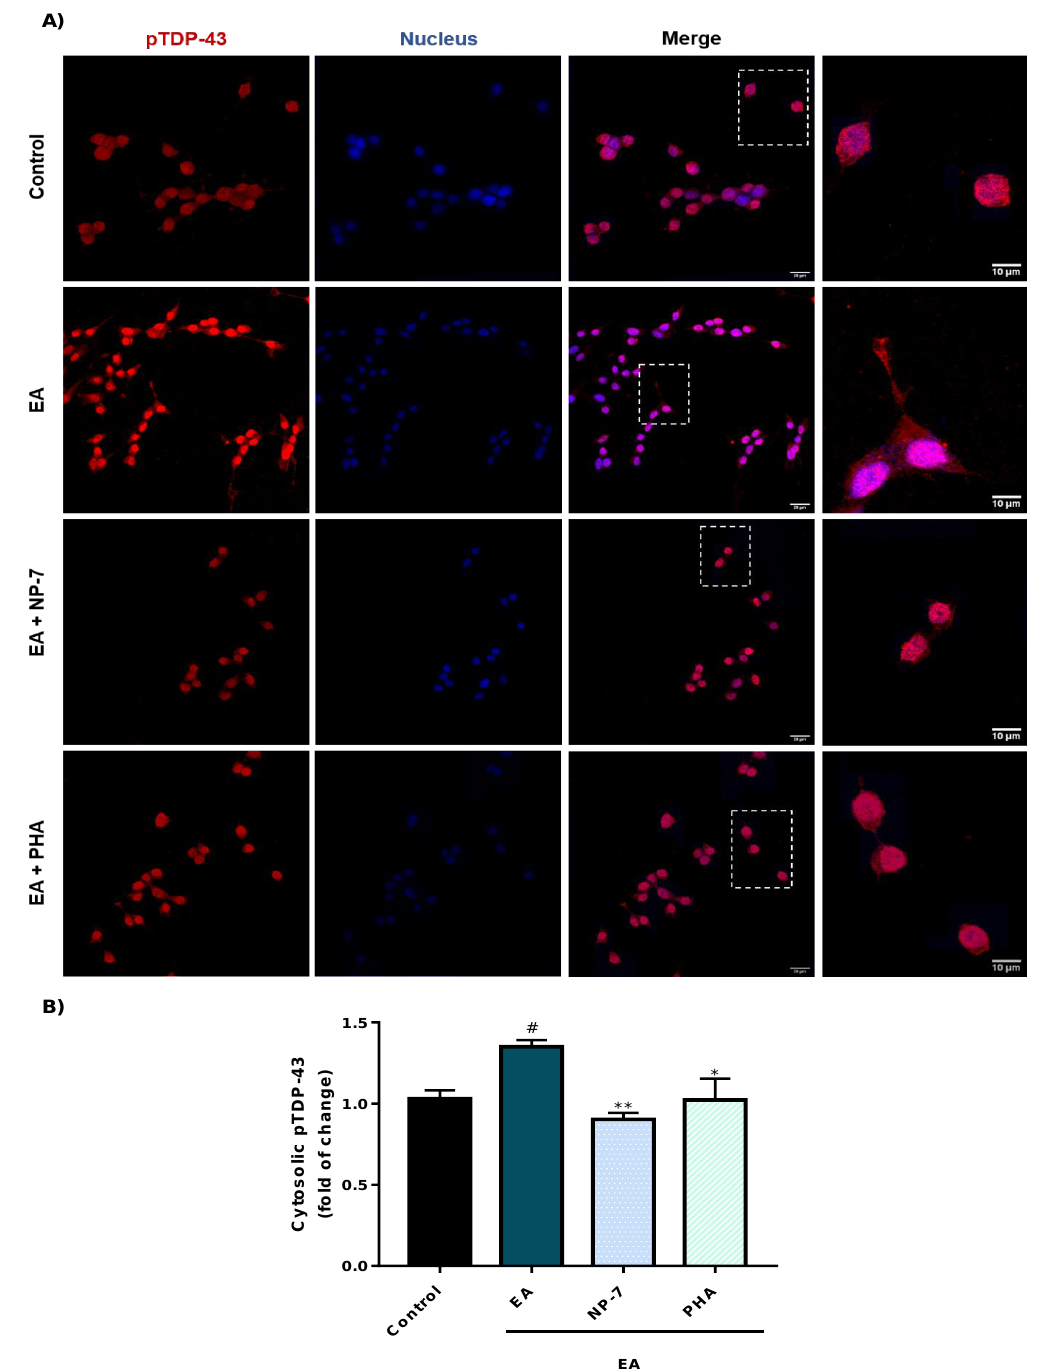
Figure 7. Immunofluorescence analysis of the TDP-43 phosphorylation in SH-SY5Y cells exposed to EA after PHA and NP-7 treatment. ( A ) Cells were pre-treated with PHA (0.5 µM) or NP-7 (0.5 µM) and exposed to EA (40 µM). NP-7 concentration was calculated referred to encapsulated PHA so cells were exposed to the same amount of PHA. Cytosolic pTDP-43 levels were assessed by confocal laser scanning microscopy. Scale bars: 10 µM and 20 µM. ( B ) Quantification of fluorescence intensity of cytosolic pTDP-43 was determined in at least 50 different cells from 3 separate wells ( n = 3). Data represent the mean ± SEM (magnification 63×). (* p < 0.05, ** p < 0.005 significantly different from SH-SY5Y EA-treated cells, # p < 0.05, significantly different from control).